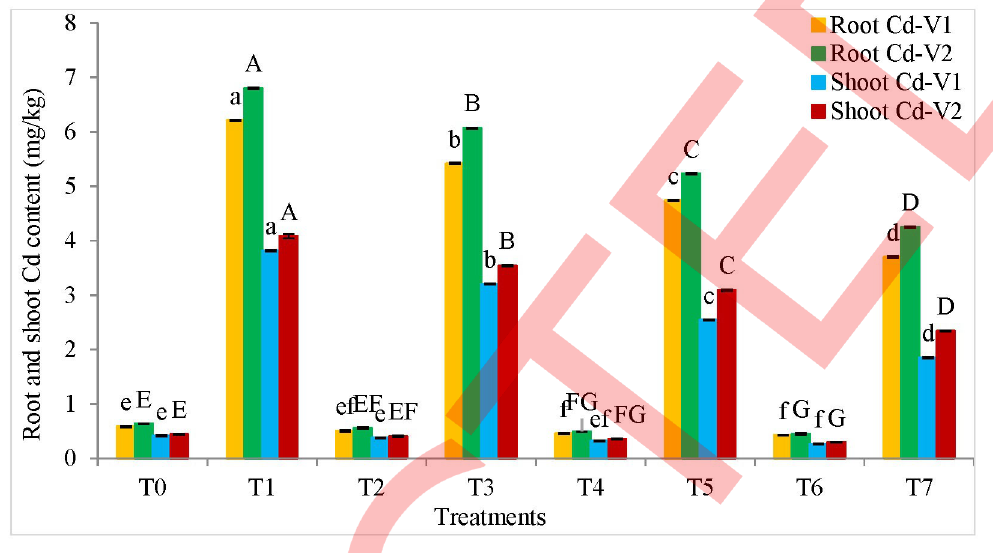
Fig 4. Effect of biochar and compost on cadmium concentration in root and shoots of spinach under cadmium stress. The mean of three replicates and standard deviation are presented. Different letters show the significant difference among treatments. Treatments as mentioned in Fig